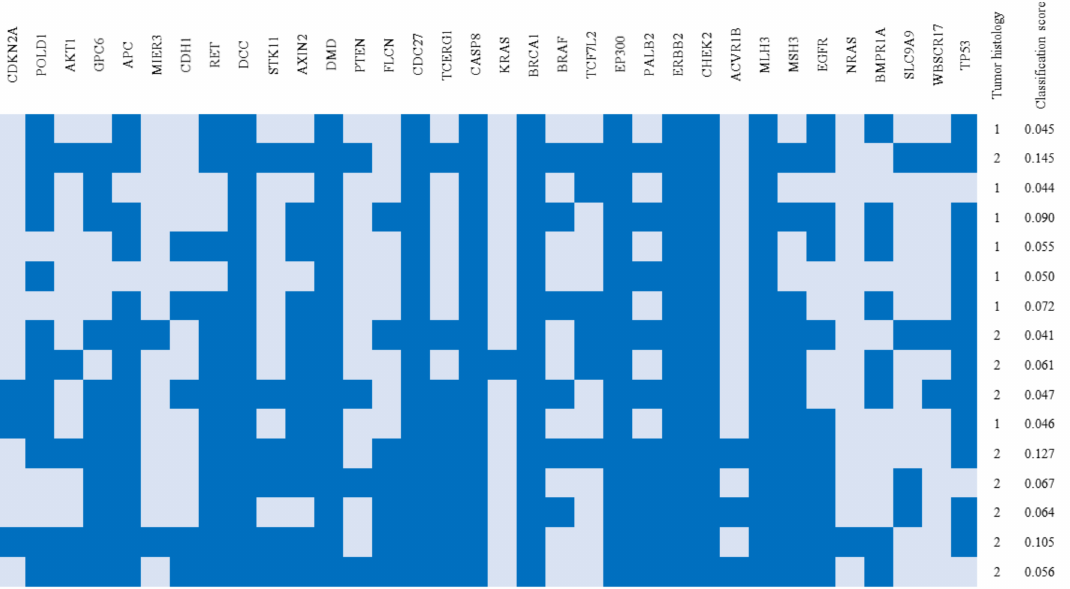
Figure 5. The summary of ctDNA sample classification compared with histology evaluation. The columns contain information regarding the genes that had nonsynonymus, stop gain or frameshift mutations in the corresponding samples (marked in dark blue). Tumor histology: 1–endometrioid,